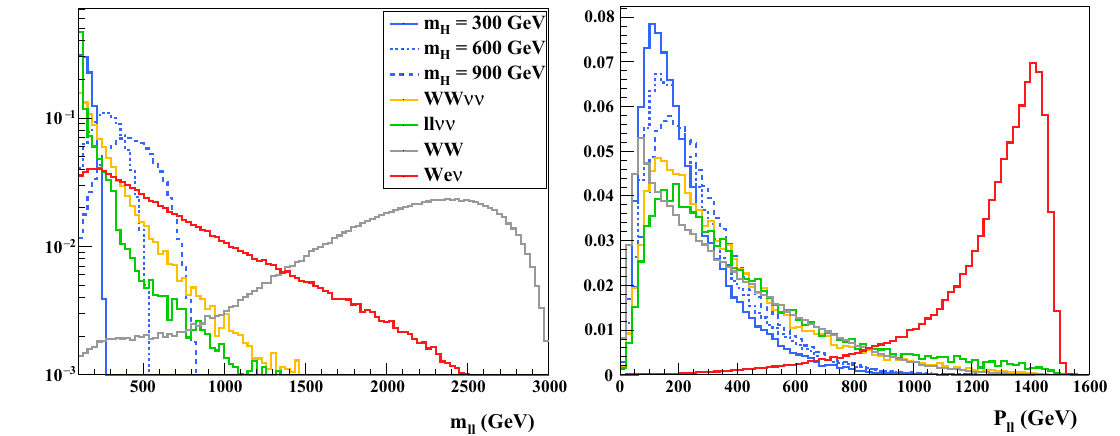
Fig. 5 Normalized kinematic distributions m (cid:2)(cid:2) (left) and P (cid:2)(cid:2) (right) for the signal e + e − → H νν ( H → WW → 2 (cid:2) 2 ν ) with m H = 300 GeV (solid blue), 600 GeV (dotted blue), 900 GeV (dashed blue) and